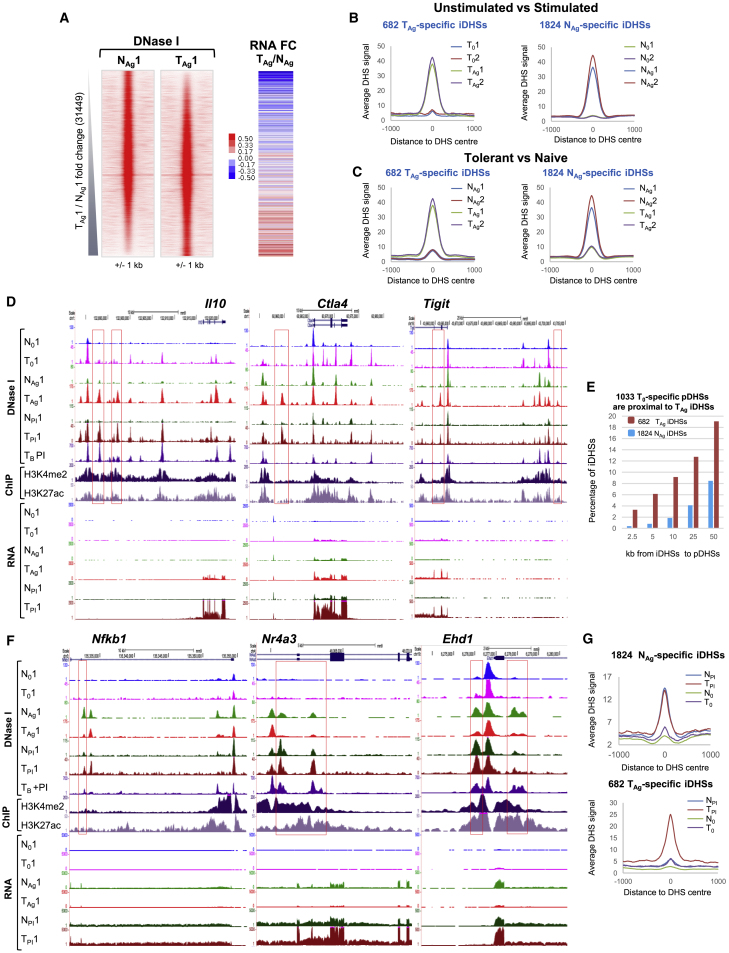
DNase-Seq Analyses of In Vivo-Activated Naive and Tolerized T Cells(A) DNase-seq tag density plots showing all peaks detected in replicate 1 of NAg and TAg ranked according to FC of sequence tag count for TAg compared with NAg. Alongside is the FC in mRNA level for the closest gene to the DHSs for TAg compared with NAg.(B and C) Average DHS signal at the 682 TAg-specific iDHSs (left) and at the 1,824 NAg-specific iDHSs (right) for 0 compared with Ag (B) and NAg compared with TAg (C).(D) UCSC genome browser tracks showing DNase-seq and RNA-seq data from resting cells (N0 and T0), antigen-stimulated cells (NAg and TAg), and PI-stimulated cells (NPI and TPI). DNase-seq, H3K27ac ChIP, and H3K4me2 ChIP tracks are shown for CD4 TB PI.(E) Bar graph showing the percentage of iDHSs that are preferentially induced in TAg or NAg that are found within 50 kb of the 1,033 tDHSs.(F) UCSC genome browser tracks as for (D).(G) Average DNase-seq signal for the 1,824 NAg-specific iDHSs and the 682 TAg-specific iDHSs in non-stimulated (N0 and T0) and PI-treated (NPI and TPI) cells.